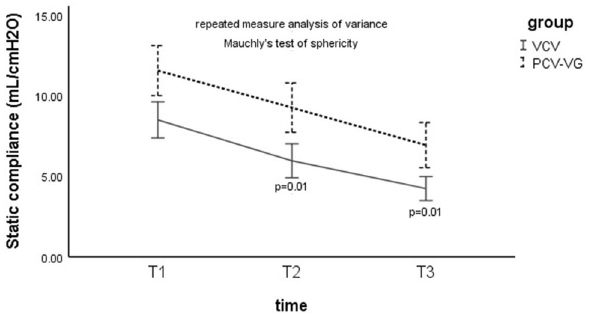
Figure 3. Static compliance in the two groups at different stages of the study. T1, 10 min after induction of anaesthesia in the supine position without pneumothorax; T2, 5 min after OLV commencement; T3, 5 min